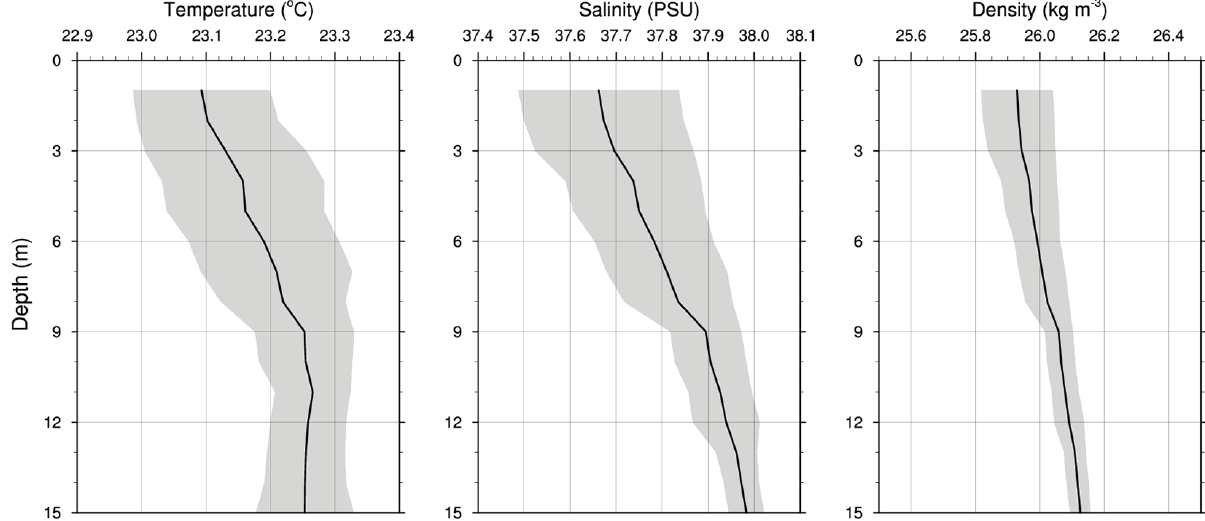
Figure 9. Mar Grande horizontal average temperature (left), salinity (center) and density (right) profiles for 5 October 2014. The grey shaded areas represent standard deviations from the